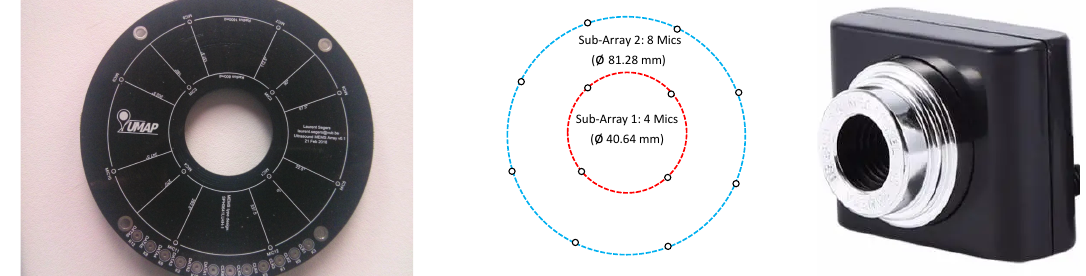
Figure 3. The microphone array ( left and center ) consists of 12 digital Micro Electro-Mechanical Systems (MEMS) micro- phones arranged in two concentric sub-arrays. The low-cost Universal Serial Bus (USB) Red-Green-Blue (RGB) Camera ( right ) achieves resolutions up to 640 480 ×